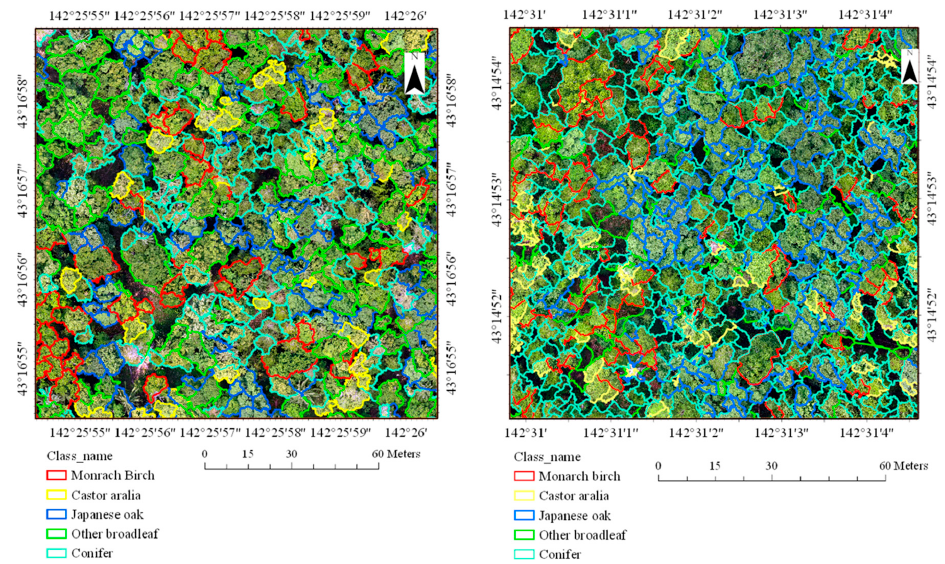
Figure 6. Individual tree crowns derived from the RF classification, where each tree crown also indicates the individual tree’s spatial position: ( a ) sub-compartment 36B and ( b ) sub-compartment 59A.